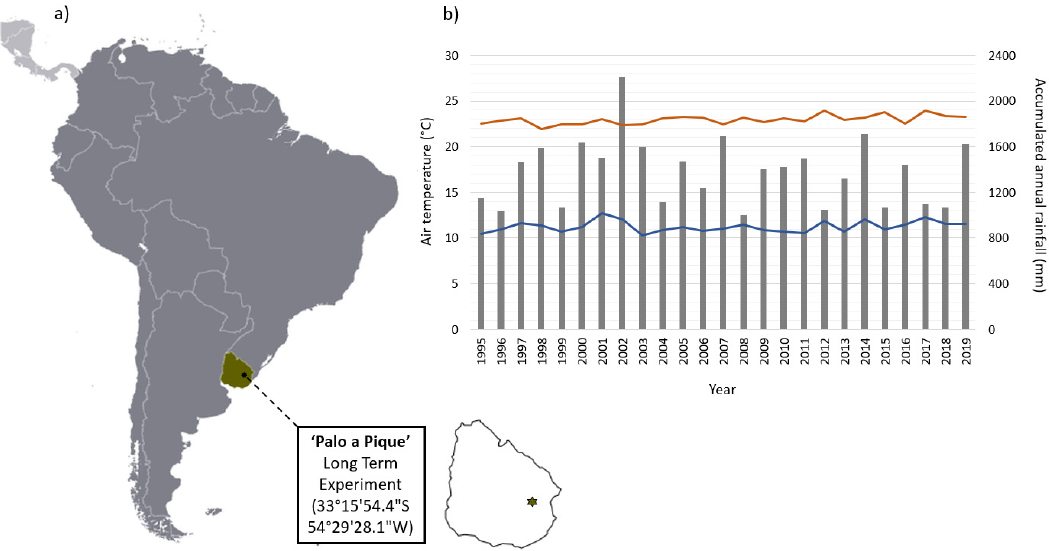
Figure 1. Location of the ‘Palo a Pique’ long-term experiment of the National Institute of Agricultural Research (INIA) in Uruguay ( a ), and annual accumulated rainfall (grey bars), mean maximum air temperature (orange line) and mean minimum air temperature (blue line) from 1995 to 2019 ( b ).